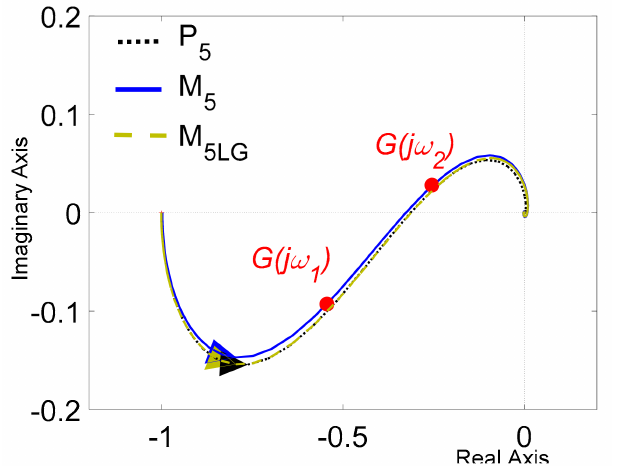
Figure 21. The Nyquist frequency plots of transfer functions P 5 ( s ), M 5 ( s ), and M 5LG ( s ). The model M 5LG ( s ) was derived in [11] (p. 235) with algorithms RU-SA and RU-SB, which result in very similar models.